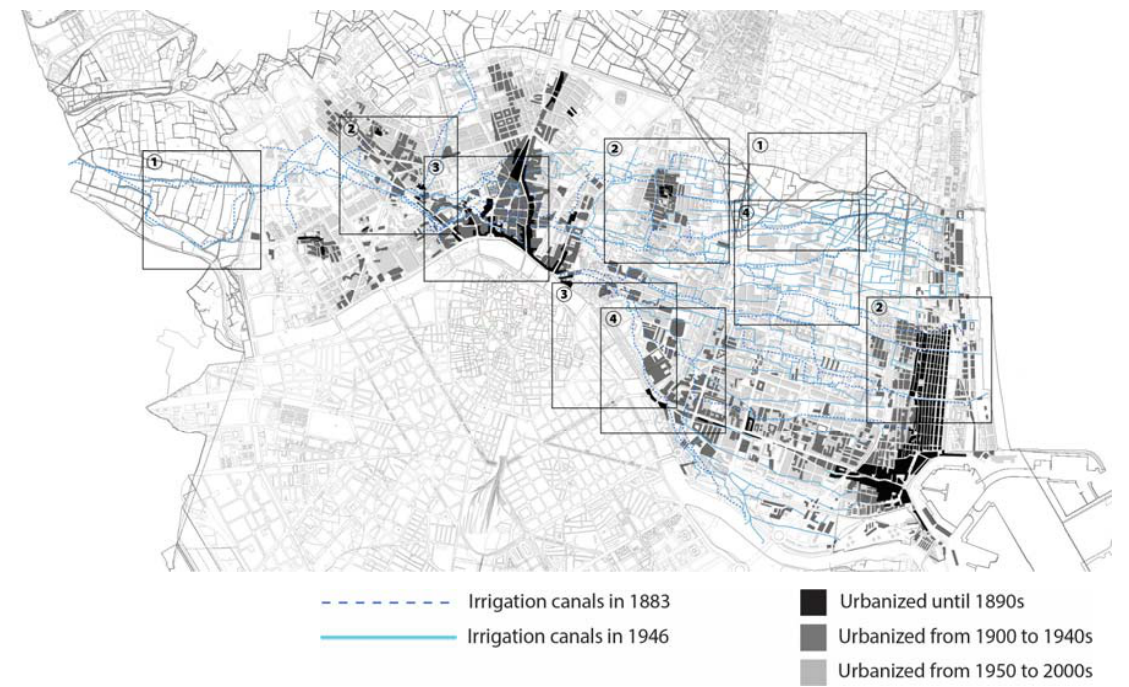
Figure 4. ( 1 (cid:13) – 4 (cid:13) ) The transformation of the irrigation canals and the phases of urbanization acequia de Mestalla.